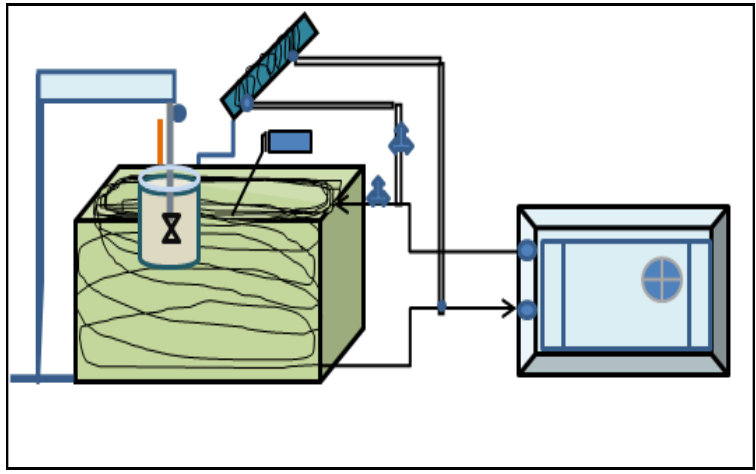
Fig. 2. Schematic figure of the apparatus used for preparation graphene